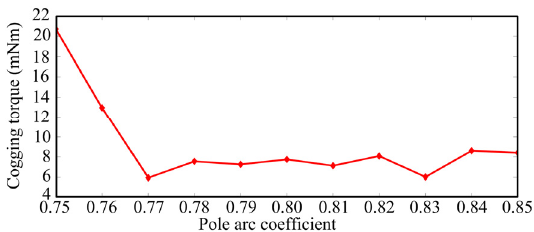
Figure 8. Effect of pole arc coefficient on cogging torque in a machine with a 4-pole and 33-slot combination.